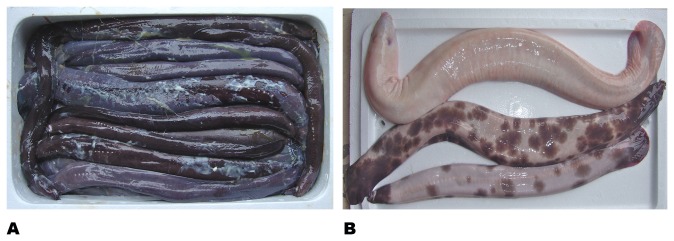
Color variations in Eptatretus cirrhatus.
(a) Typical fresh specimens have a solid color ranging from burgundy to a chocolate brown.(b) These are two of three piebald specimens and the only albino animal collected.